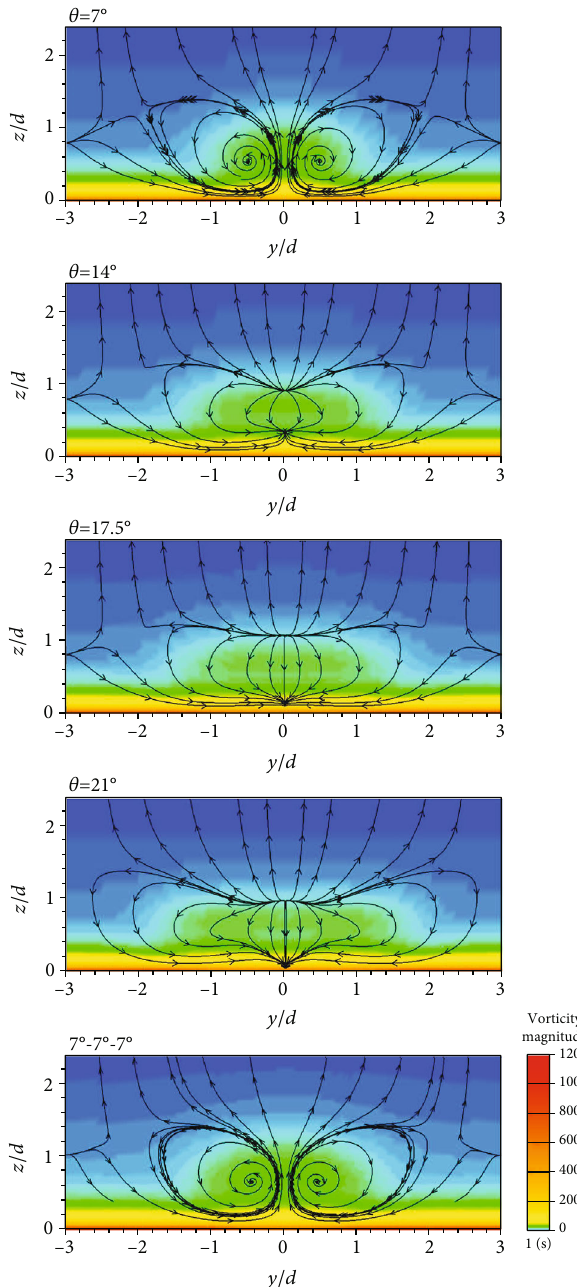
Figure 17: CFD vorticity magnitude contours for M = 0 : 5 at x / d = 5